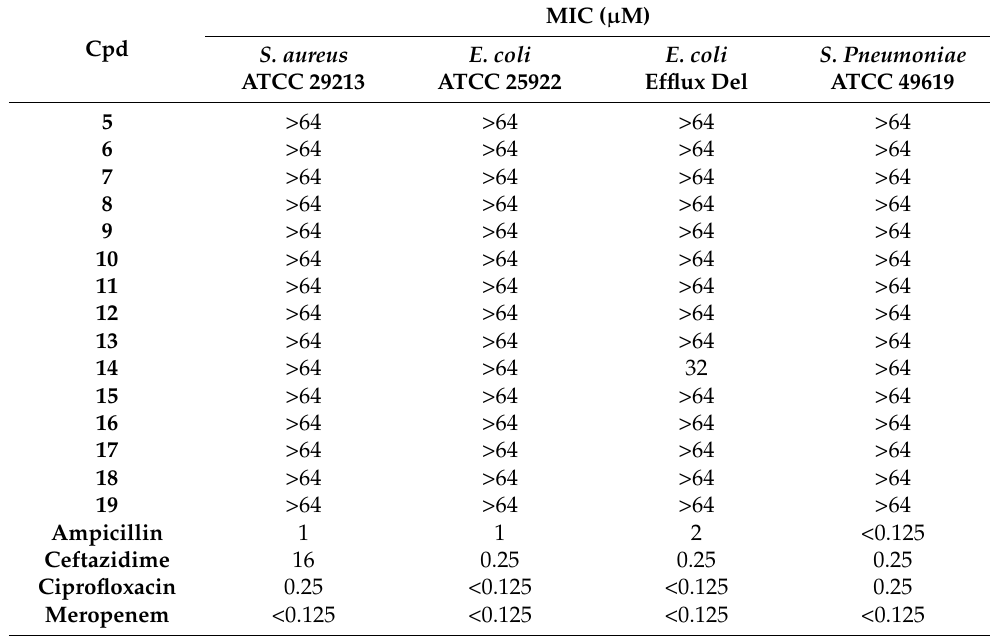
Table 3. Antibacterial activity in